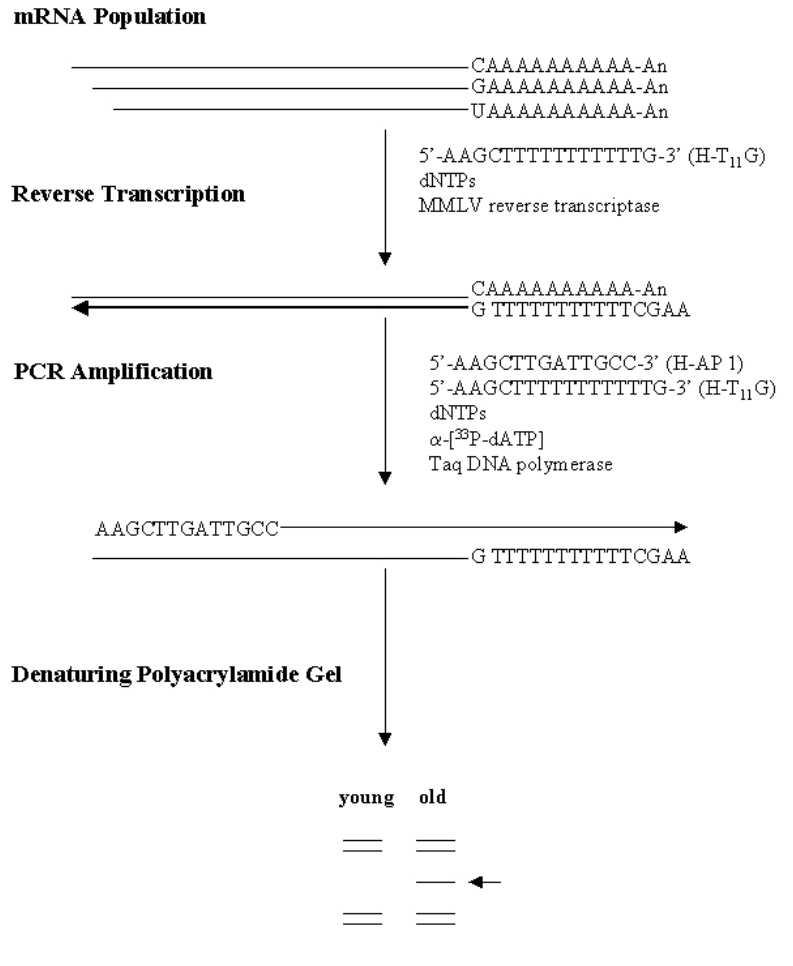
FIGURE 2. Schematic diagram of the